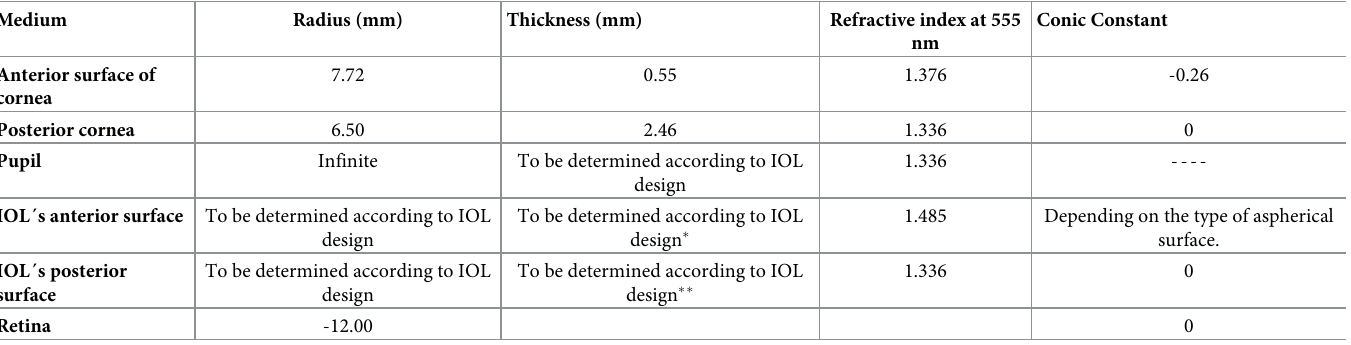
Table 1. Eye model and parameters used for designs and